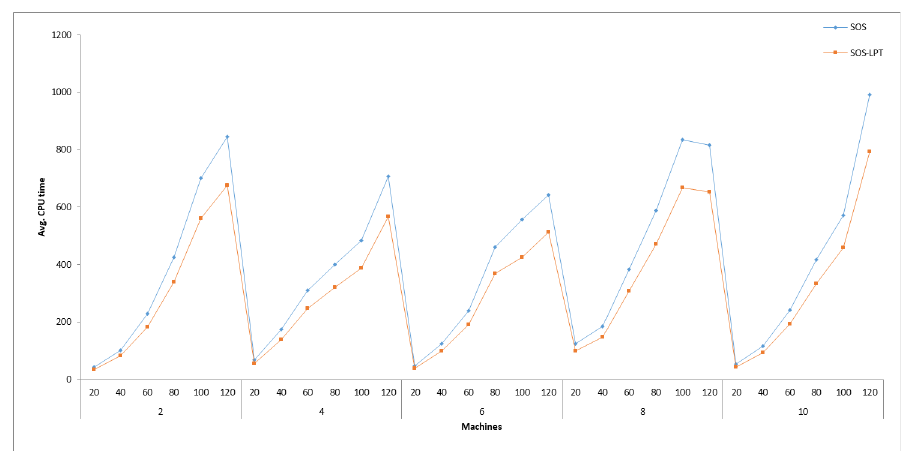
Fig 2. Comparison of SOS and SOS-LPT average CPU execution